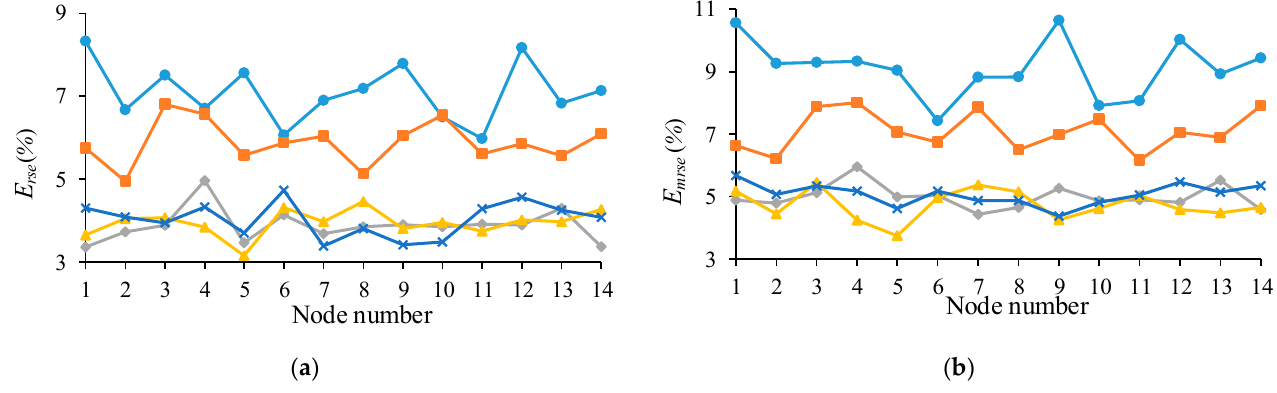
Figure 11. ( a ) E rse % of different equivalent WT numbers (clustering); ( b ) E mres % of different equivalent WT numbers (clustering). Where light blue with circular line represents 2 machine equivalent, orange with square line represents 3 machine equivalent, gray with diamond line represents 4 machine equivalent, yellow with triangle line represents 5 machine equivalent, dark blue with × line represents 6 machine equivalent.